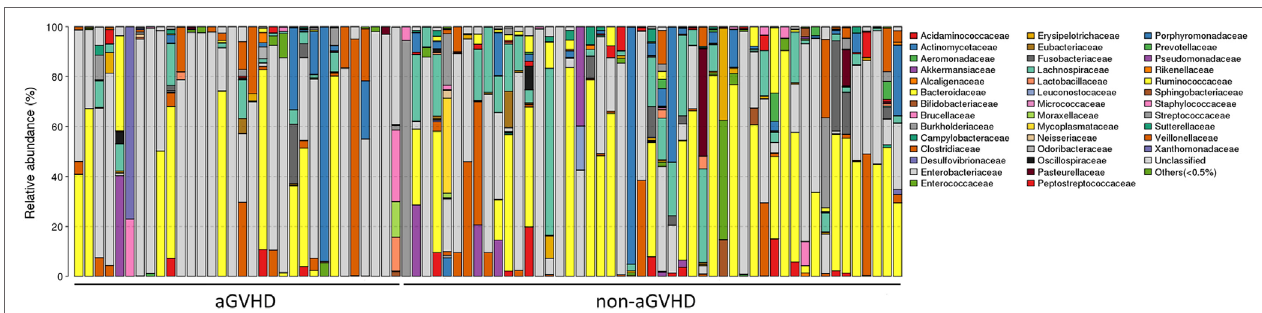
FigUre 2 | The intestinal ecosystem at engraftment between acute graft-versus-host disease (aGVHD) and non-aGVHD patients. Each rank is a study subject, which represents the phylogenetic composition of each subject. The relative abundance of intestinal bacterial taxa is shown.